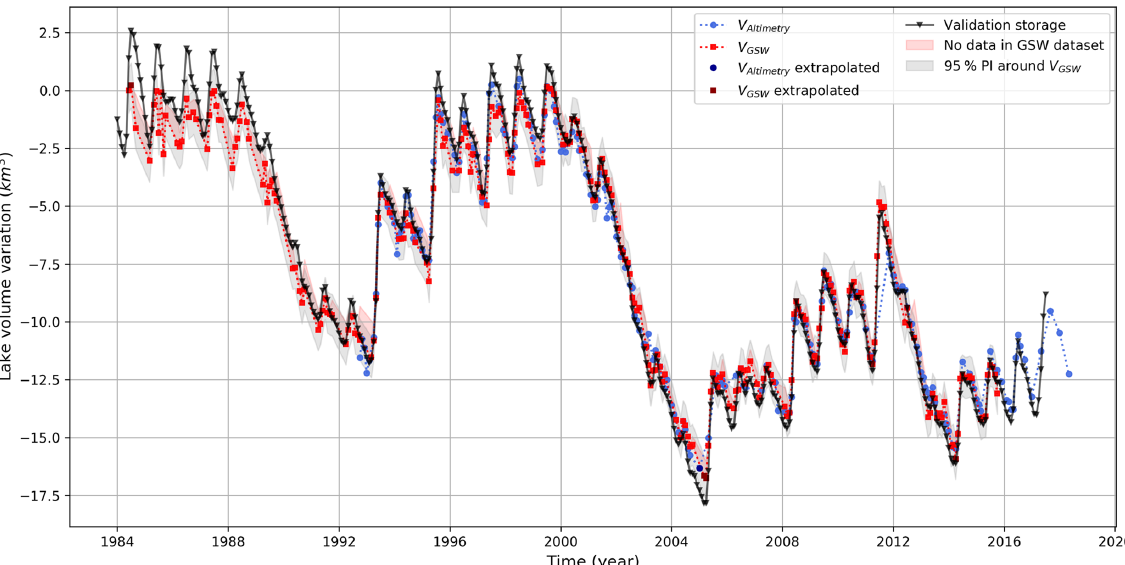
Figure 10. Validation time series plotted with estimated reservoir volumes for Lake Powell. The black triangle line represents the validation storage as measured using the full lake